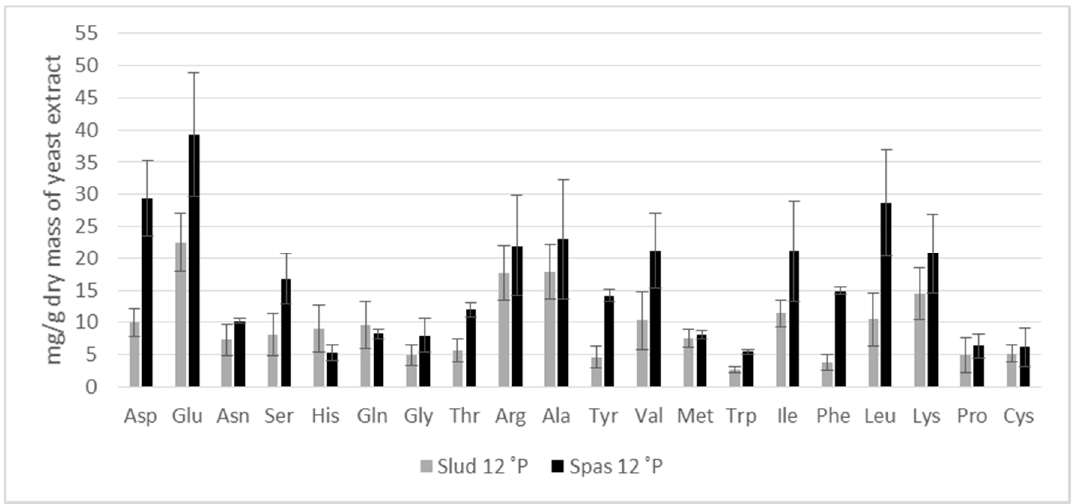
Figure 4. Free proteinogenic amino acid spectrum in yeast extracts made from spent yeast (S. pastorianus TUM 34/70 and S. ludwigii TUM SL 17) after primary fermentation via autolysis; for results of ANOVA and pairwise t-test, see text; data are expressed as mean values ± confidence limits .